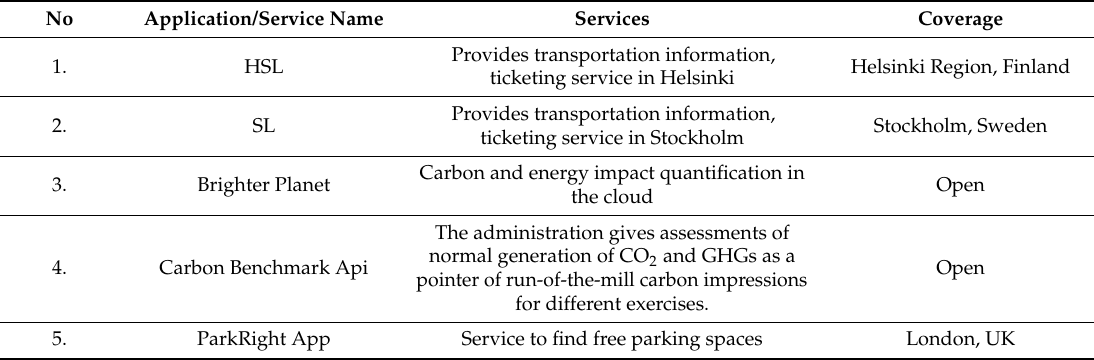
Table 2. List of smart city applications or services. UK—United